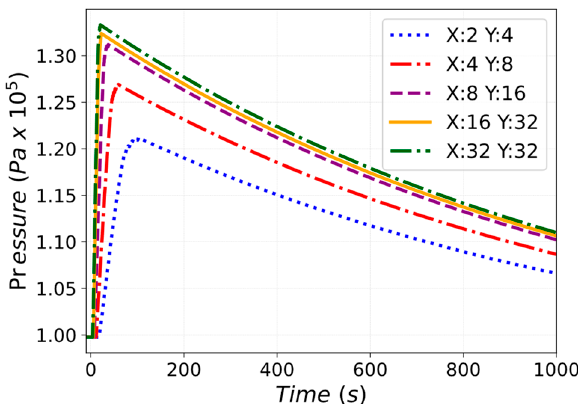
Figure 22. Pressure in the TMH for different numbers of relief panels.